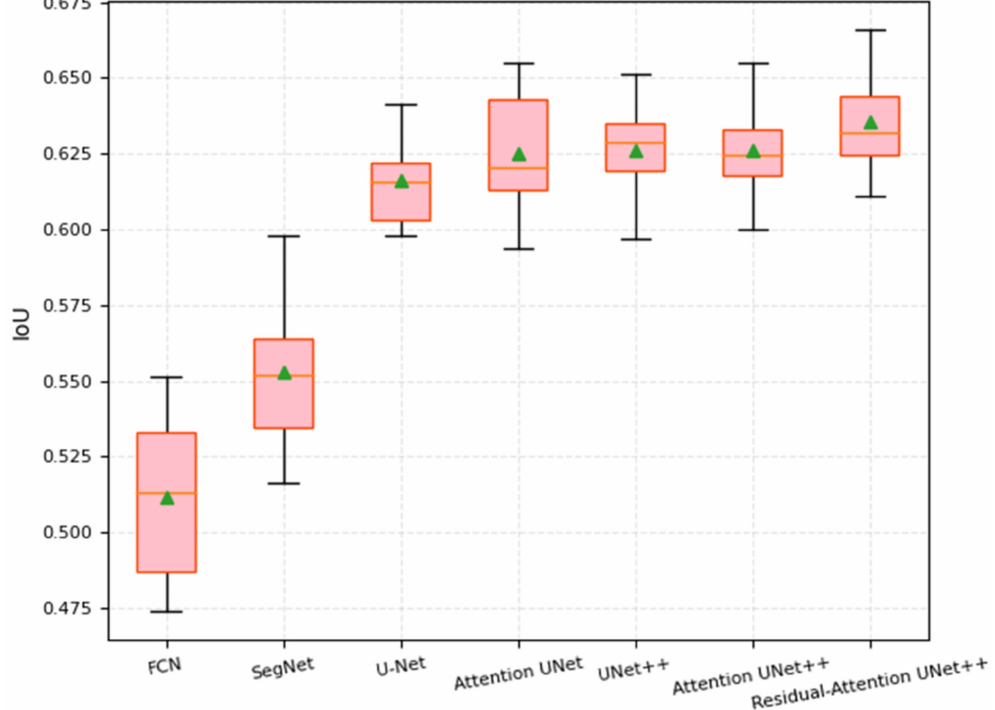
Figure 16. The comparison between Residual-Attention UNet++ and other methods on IoU after multiple experiments for angiography